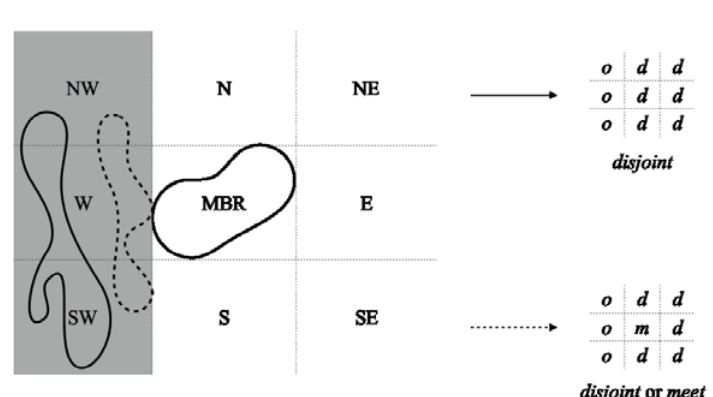
Figure 17: The impact of topological augmentation on the possible topological relations between a direction relation matrix symbol and a ground object. By observing the relation meet with the MBR tile, the relation meet with the object is possible, but not guaranteed. If the relation had been disjoint for this particular tile, the relation meet for the objects is not